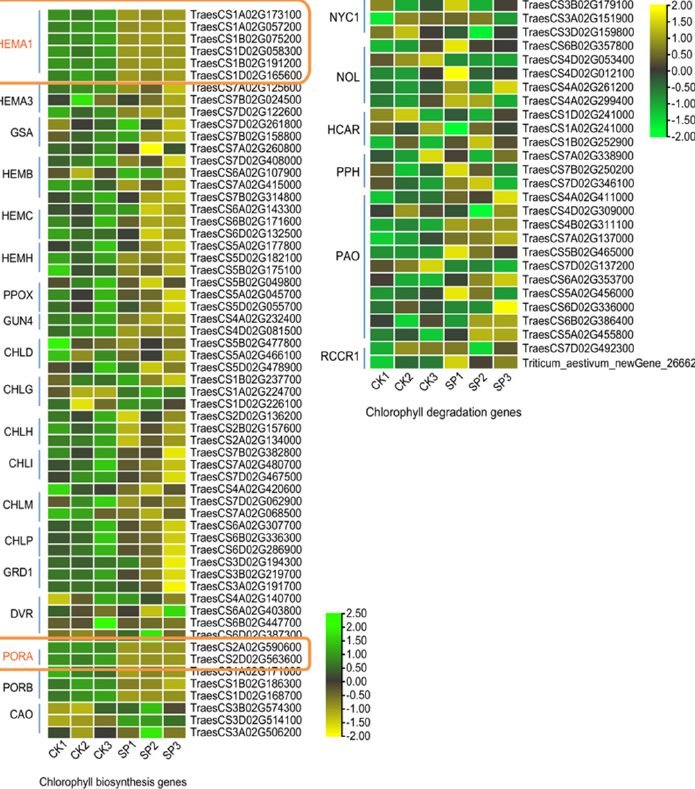
Figure 4. Expression profiling of genes involved in chlorophyll metabolism. Note: The relative expression values range from − 2 to expression values range from − 2 to 2.